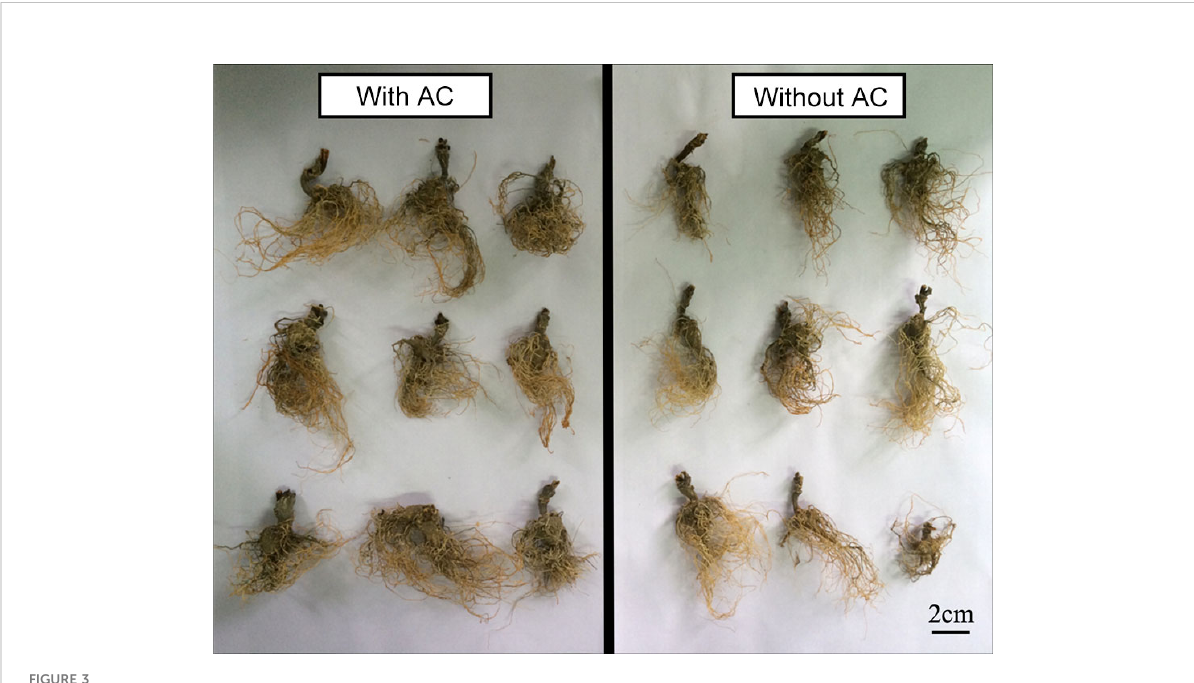
FIGURE 3 Dry root of P. notoginseng either with or without AC addition in hydroponics. TABLE 2 Physiological indexes of P. notoginseng either with or without AC addition in hydroponics.